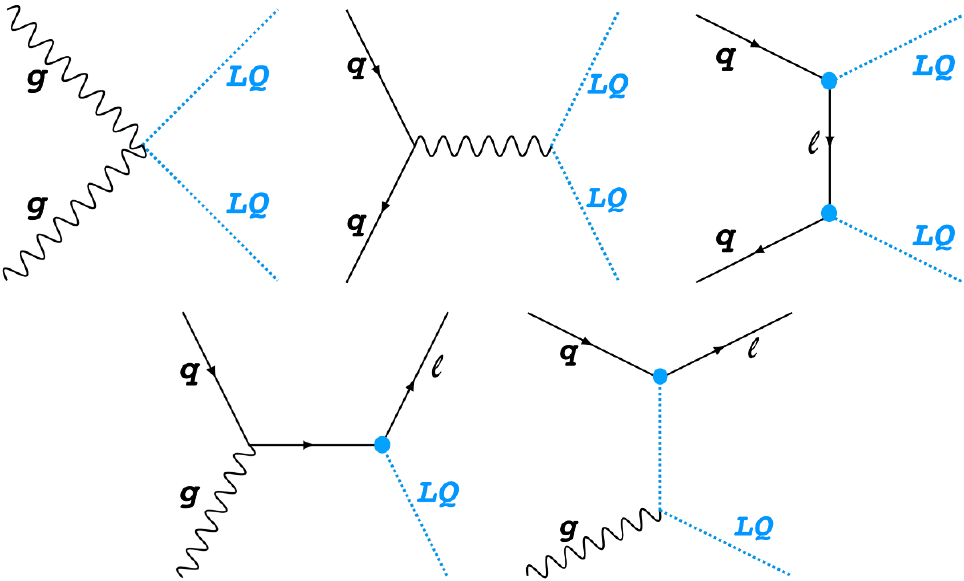
Figure 1 . A sample of leading order Feynman diagrams for the scalar LQ pair production (top row) and single scalar LQ plus lepton production (bottom